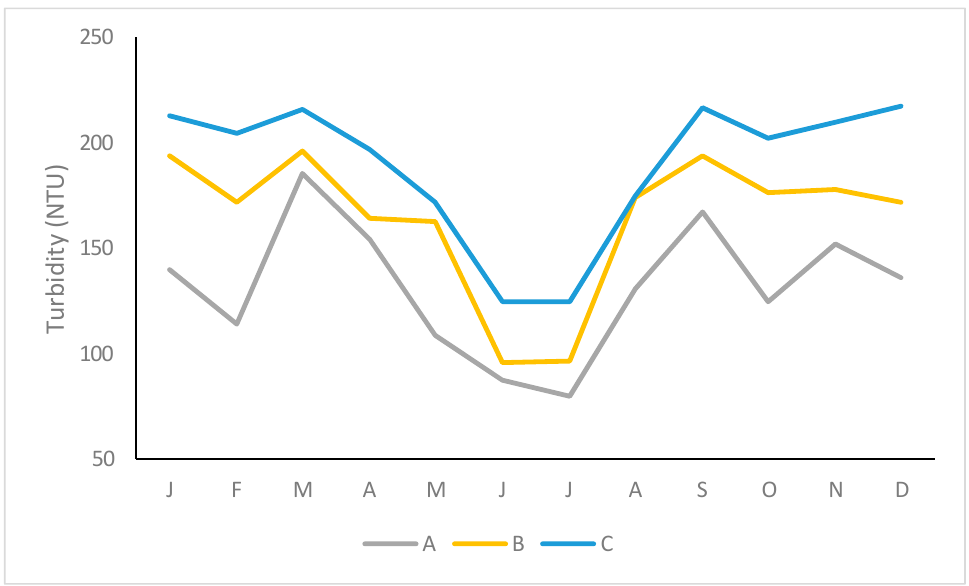
Figure 5. Temporal variability of turbidity. A: rural area, B: poor community, C: rich neighbourhood.